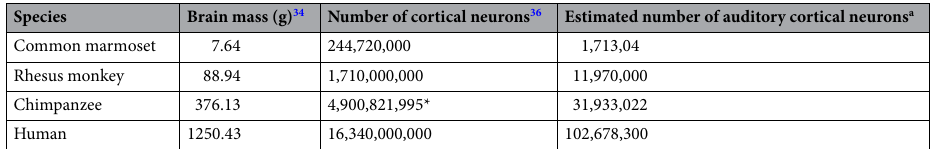
Table 1. Brain size and number of neurons in the four primate species investigated in this study. *Predicted from brain mass by using equation in 57 . a See “Supplementary analysis of allometry” in the “Results” section for the estimation